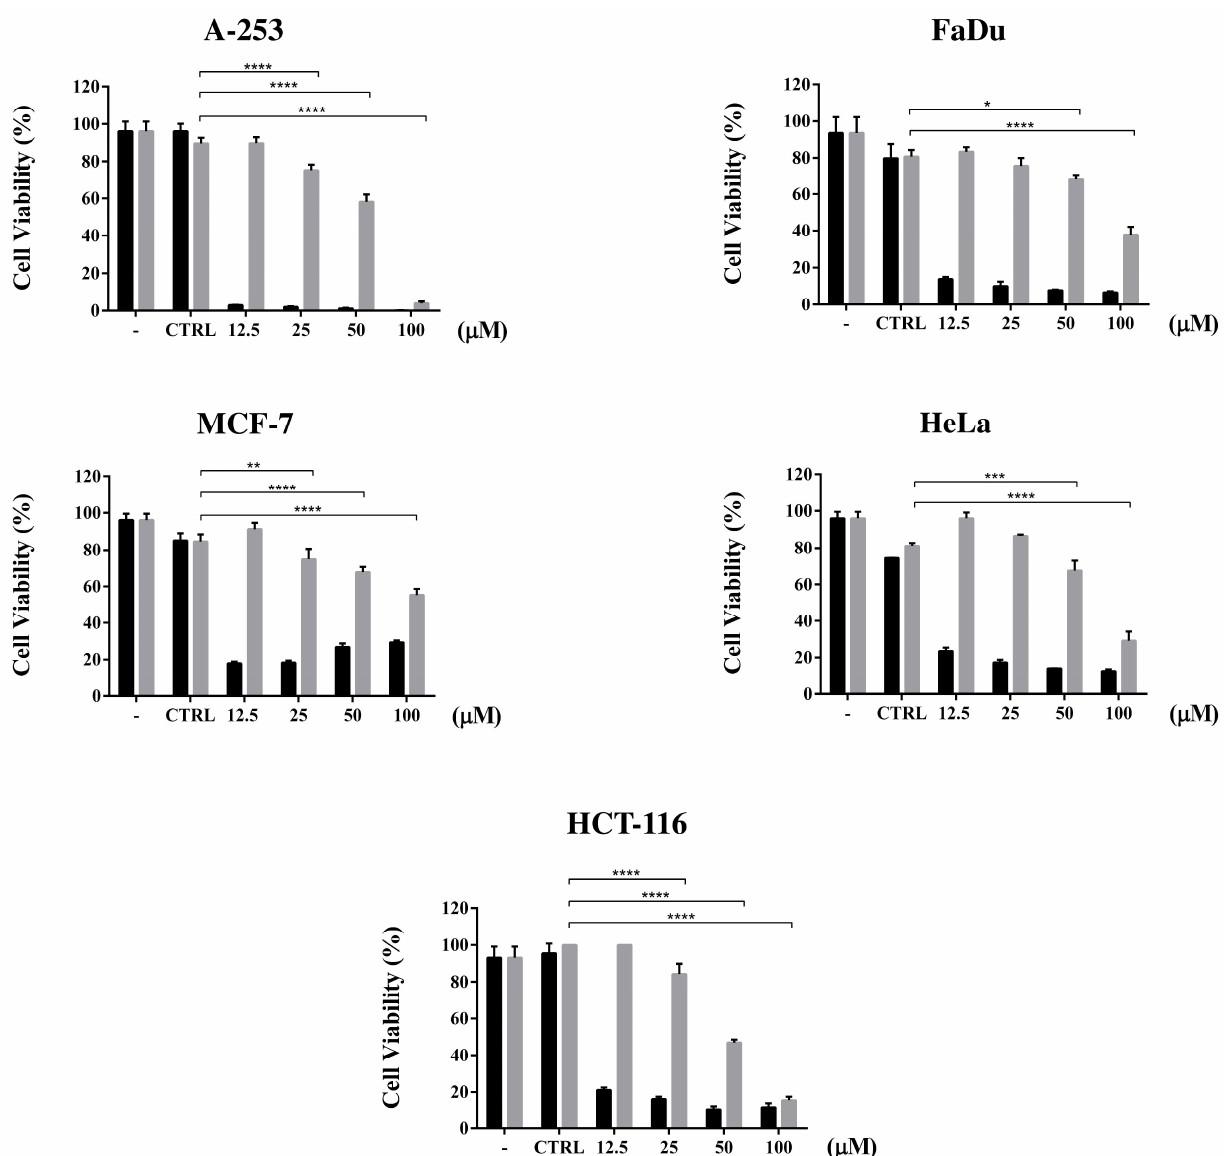
Figure 6. Dose dependent cell viability assay. The figure shows a dose dependent viability in the presence of different concentrations of DM, ranging from 12.5 to 100 μM (gray bars). As positive cytotoxicity control, the cells were incubated with TPT (black bar), as well for 48 h at 37 °C, 5% CO 2 . (-) is the positive control while CTRL represents the cells incubated with the appropriate drugs solvent, DMSO and ACN for TPT and DM, respectively. The reported data represent cumulative experiments with mean ± SD values. Asterisks indicate * p ≤ 0.05, ** p ≤ 0.01, *** p ≤ 0.001 and **** p ≤ 0.0001.